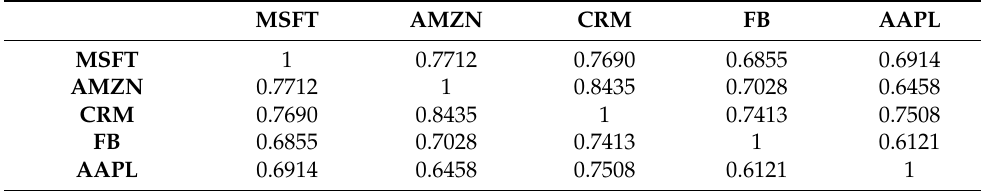
Table 1. The correlation matrix for N = 5 assets.